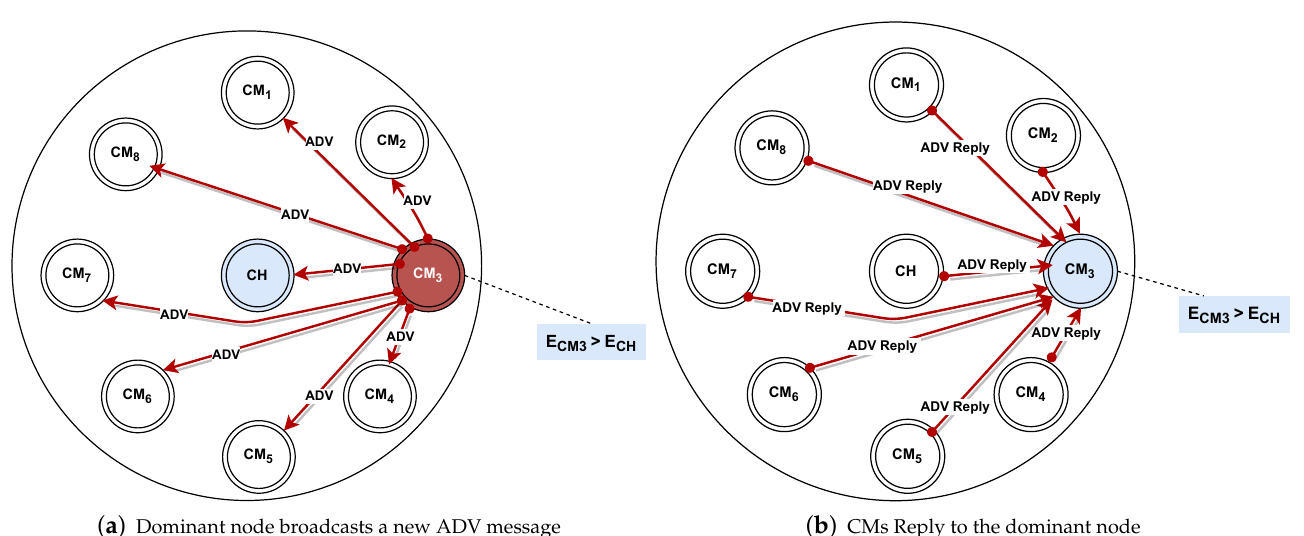
Figure 7. Maximum Residual Energy Node Broadcast ADV Message. ( a ) Dominant node broadcasts a new ADV message; ( b ) CMs Reply to the dominant node.